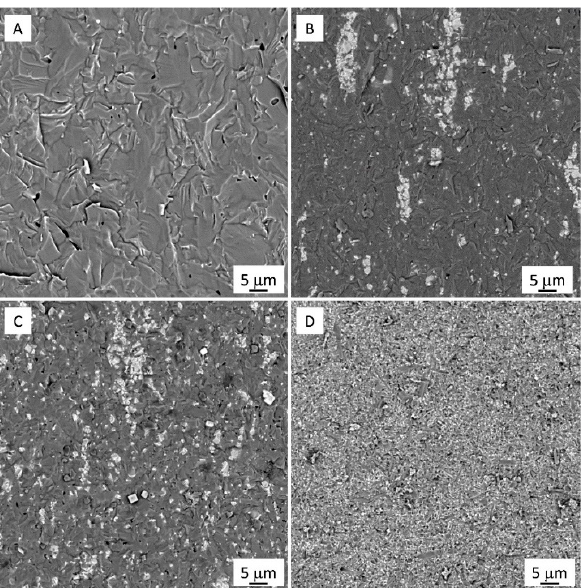
Figure 5. SEM micrographs of fracture surface of ( A ) α - β 0T, ( B ) α - β 10T, ( C ) α - β 20T, and ( D ) TC3030 ceramics.